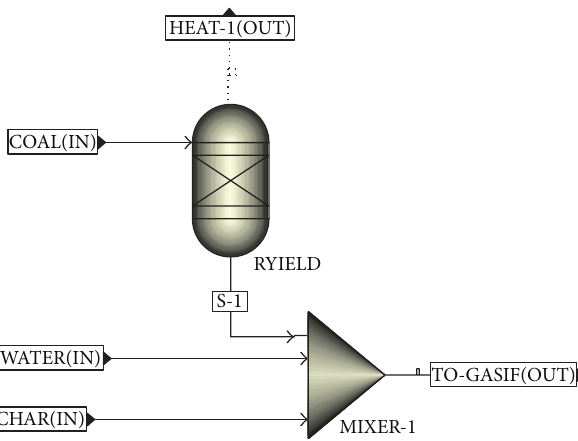
Figure 4: Aspen Plus feeding hierarchy for the simulation of the slurry preparation in the SNG production via coal